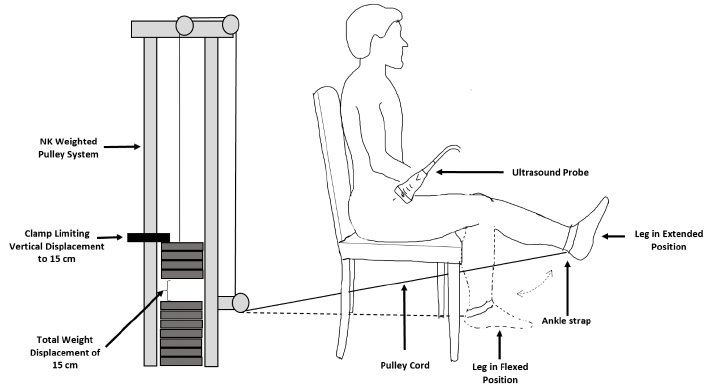
Figure 1. Illustration of Experimental Setup for Knee Extension Exercise. Subjects performed con- centric and eccentric knee extension exercises with their ankle attached to a cable-based pulley sys- tem. The vertical displacement of the pulley was limited to 15 cm by placing a clamp 15 cm above the weight stack. The pulley system was adjusted so that knee flexion was 90° at rest. Leg blood flow in the common femoral artery was measured during knee extension with a Doppler ultra- sound.